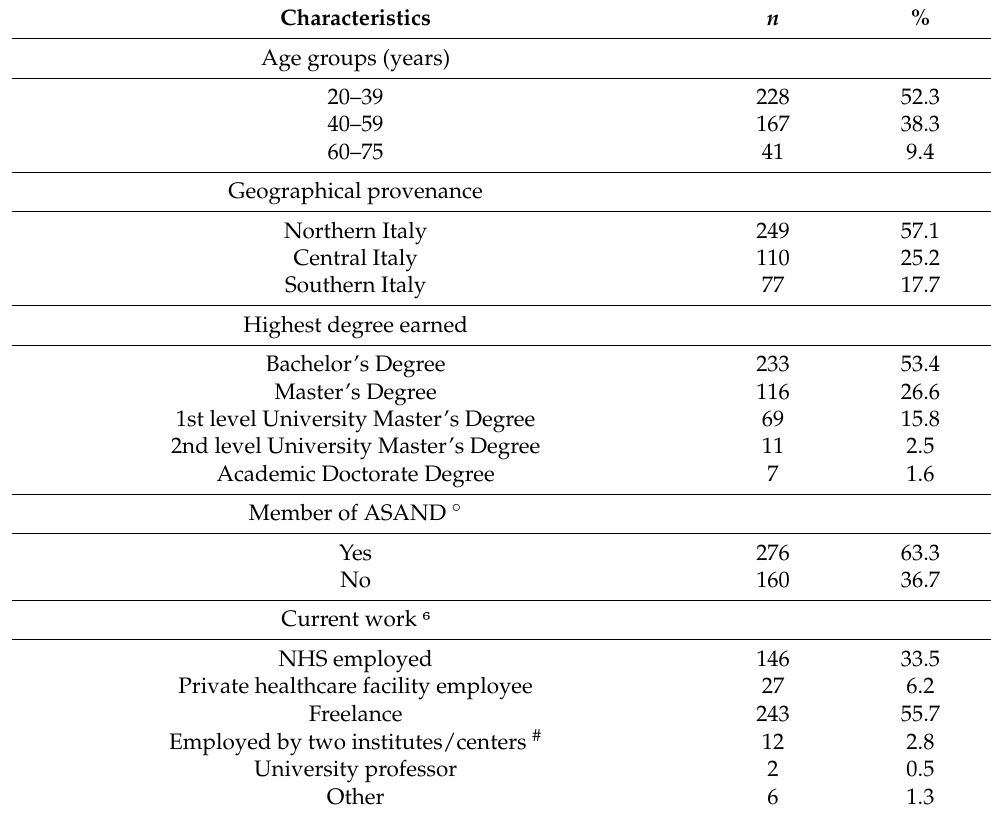
Table 1. Description of the participants’ demographic and professional charact eristics ( n = 436 ).